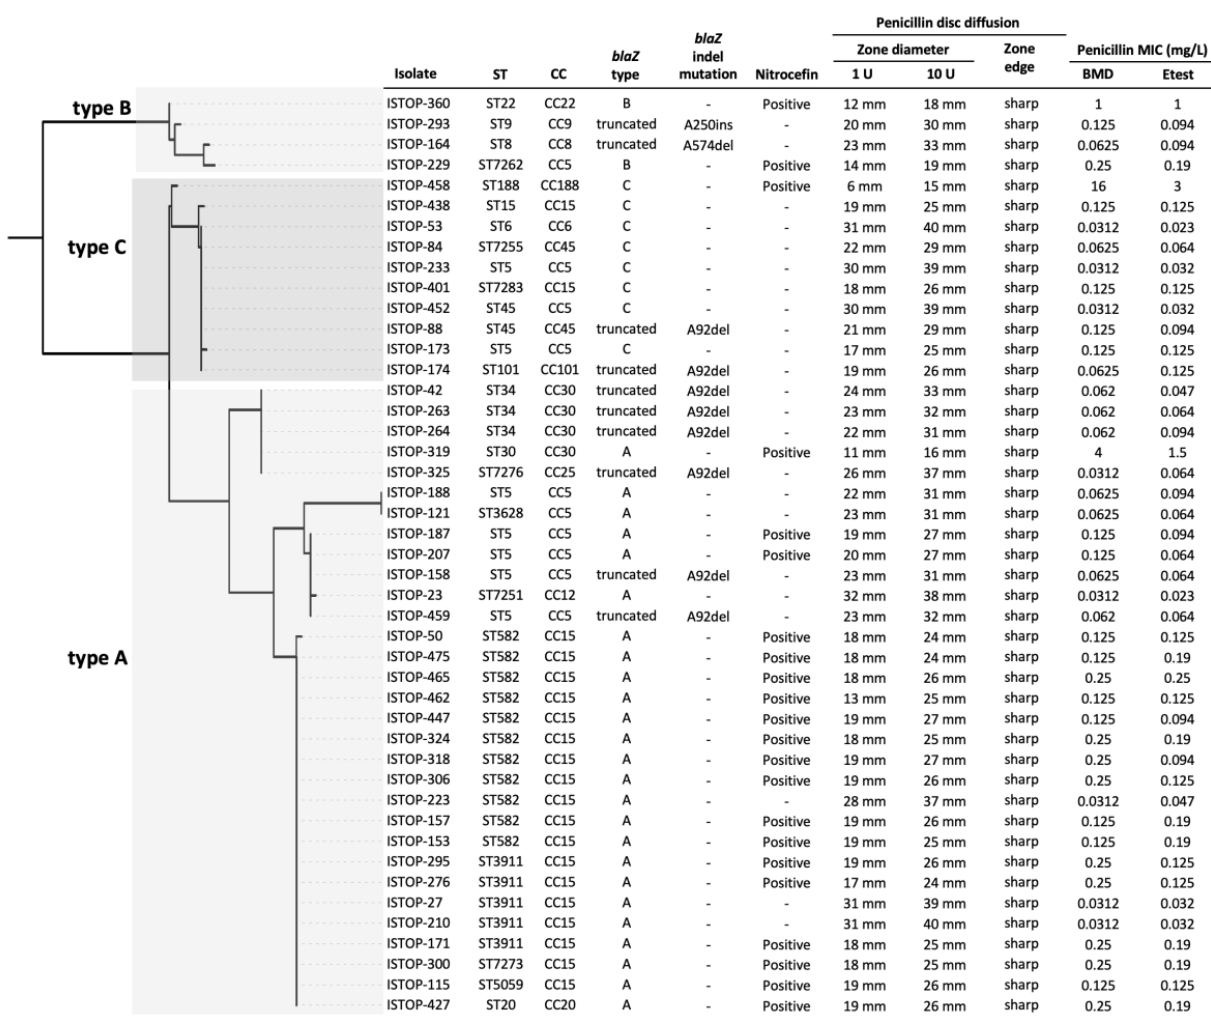
Figure 3. Phylogeny of blaZ nucleotide sequences and characteristics of the blaZ -positive isolates. The BlaZ type (A, B, C) was defined by amino acids encoded at positions 119 and 207. A truncated blaZ type was defined by the presence of a premature stop codon. ST, sequence type; CC, clonal complex; BMD, broth microdilution; A92del, deletion of an adenine at nucleotide position 92; A574del, deletion of an adenine at nucleotide position 574; A250ins, insertion of an adenine at nucleotide position 250. A truncated blaR1 was identified in 25 isolates harboring an intact blaZ . The deletion of an adenine at nucleotide position 466 (from a string of 8 adenines) was identified in 23 isolates and the insertion of an adenine at nucleotide position 221 was identified in one isolate. The remaining isolate harbored a stop codon polymorphism at codon position 244. Of the isolates harboring a truncated blaR1, 64% ( n = 16) and 80% ( n = 20) were penicillin- susceptible per the BMD and Etest ® , respectively. However, the remaining isolates had an MIC close to the breakpoint (0.19–0.25